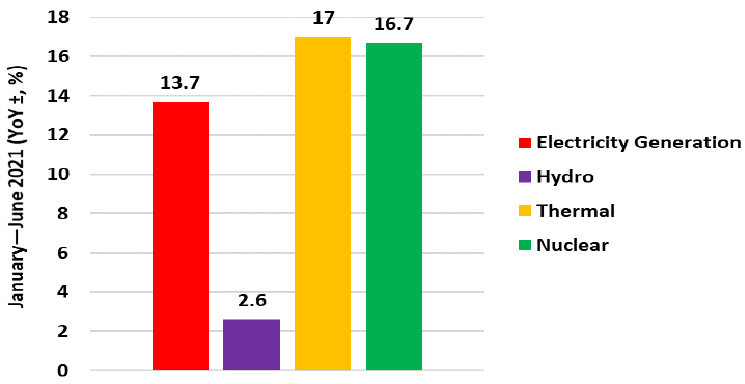
Figure 15. The industry’s electricity consumption from January to June in 2021 [75]. Source: CEC (2021) Statistics of Electricity Consumption. All rights reserved.